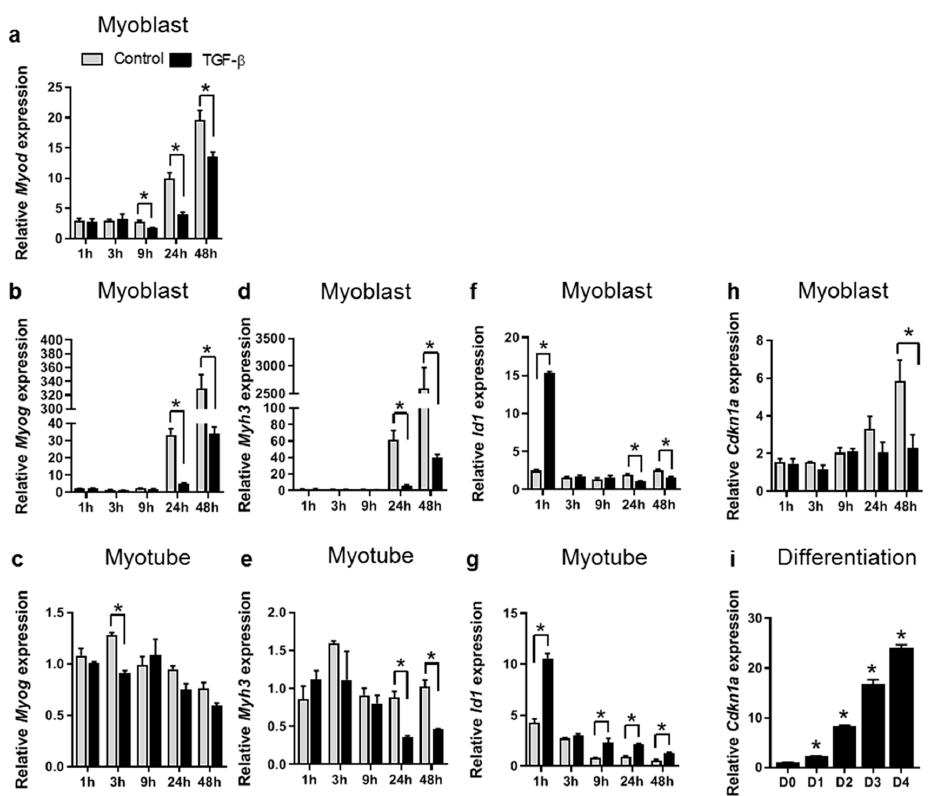
Figure 2. TGF- β reduces myogenic gene expression. ( a , b , d , f ) In myoblasts, expression levels of Myod ( a ) were reduced by TGF- β after 9 h compared to those of untreated cells, while expression levels of Myog ( b ) and Myh3 ( d ) were reduced after 24 h. Id1 expression levels ( f ) were induced after 1 h and repressed after 24 and 48 h. ( c , e , g ) In myotubes, the expression levels of Myog ( c ) were una ff ected by TGF- β , while expression levels of Myh3 ( e ) were reduced compared to those of untreated cells after 24 and 48 h. Expression levels of Id1 ( g ) were induced after 1 h and remained slightly elevated at later time points. ( h ) In untreated myoblasts, the expression levels of Cdkn1a significantly increased, while this increase was inhibited in TGF- β treated cells. ( i ) Cdkn1a mRNA expression increased during myoblast differentiation, where D0 is the start of differentiation and D1, 2, 3 and 4 are days 1 to 4 of differentiation. Gapdh served as housekeeping gene. Data were normalized to values of control cells at 0h; * indicates significant difference at p < 0.05; n = 3 experiments per condition.